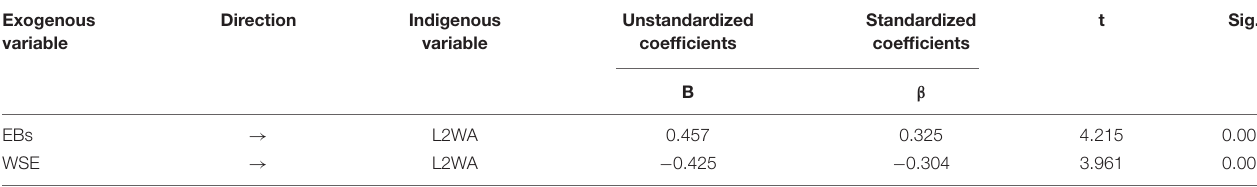
TABLE 12 | Regression analysis and coefficients a for exogenous and indigenous